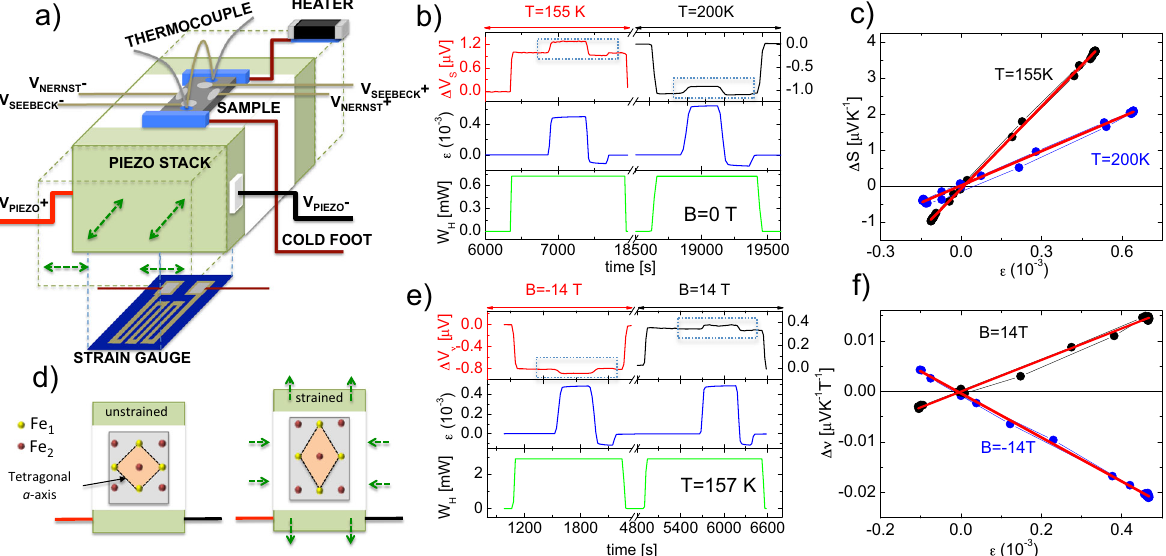
Fig. 1 The elasto-thermoelectric transport technique. a Schematic of our experimental setup. The relative size of the sample and the piezo- stack in the sketch is exaggerated: the actual size of the piezo device is 9 × 5 × 5 mm 3 , while the sample is around 1 × 1 × 0.04 mm 3 . The sample is mounted on a piezoelectric device, which expands or contracts according to the green arrows. The thermal circuit is realized with a heater and a cold foot connected to the thermal mass. The temperature gradient is measured using a chromel-Au thermocouple while two couples of electrodes measure the Seebeck voltage Δ V S and the Nernst voltage Δ V N . The applied strain ϵ is measured with a strain gauge glued on the back side of the piezo. d The sample is oriented with the tetragonal a -axis tilted of 45 degrees with respect to the piezo straining axis, so that the distortion occurs along the putative orthorhombic axis. Fe 1 and Fe 2 are the iron atoms in the Fe-As planes. b , e Time- dependence of the applied heat power W H (bottom panel), applied strain ϵ (middle panel) and resulting Seebeck ( b ) and Nernst ( e ) signals at representative temperatures and magnetic fi elds for a LaFeAsO compound. c Strain dependence of the Seebeck anisotropy Δ S = S ( ϵ ) − S ( ϵ = 0) for a single crystal of LaFeAsO at T = 155 K and T = 200 K. f Strain dependence of the Nernst anisotropy Δ ν = ν ( ϵ ) − ν ( ϵ = 0) for a single crystal of LaFeAsO at T = 157 K and B = ±14